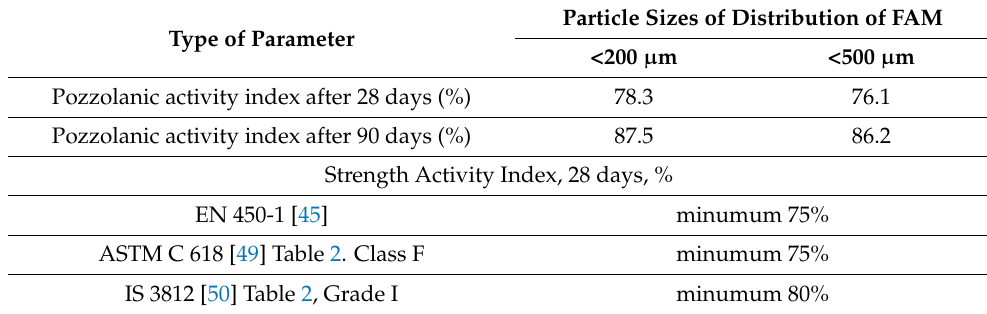
Table 4. The pozzolanic activity index for the cement mortars with FAM after 28 and 90 days. Type of